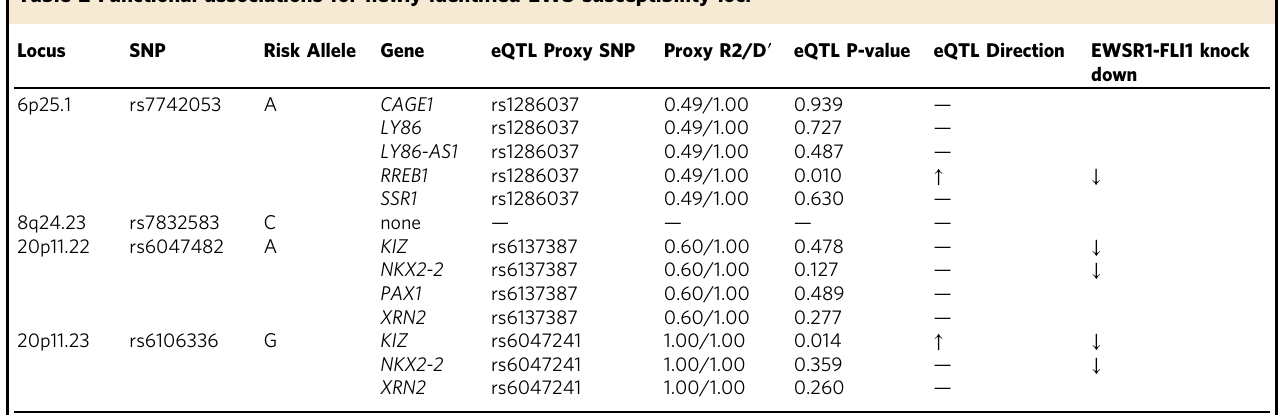
Table 1): 6p25.1, 8q24.23, and 20p11.22 and 20p11.23. To vali-